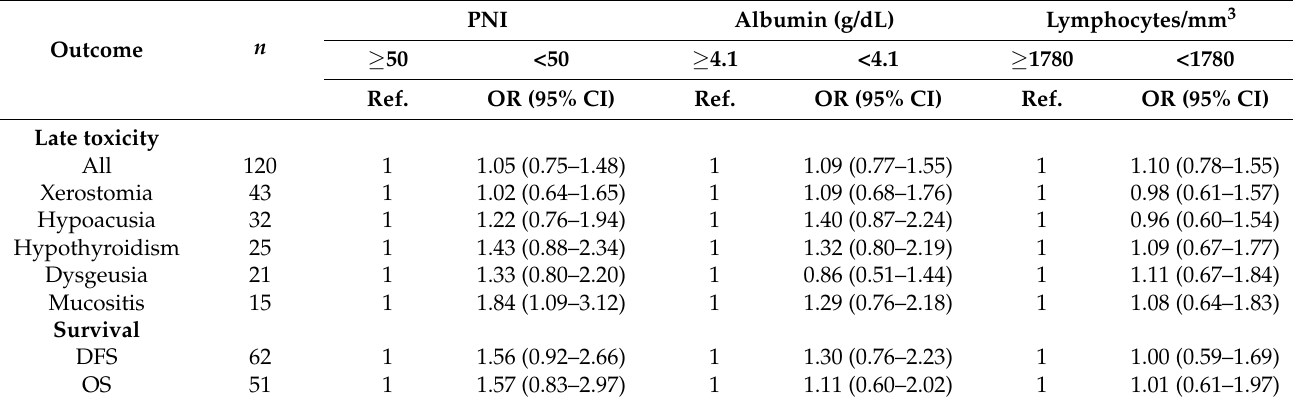
Table 3. Hazard ratio (HR) and 95% confidence interval (CI) 1 for late G2–G4 toxicity, disease-free survival (DFS) and overall survival (OS), according to nutritional